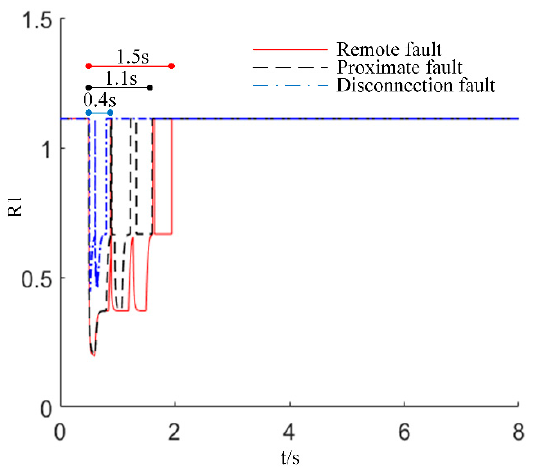
Figure 13. The fuzzy amplitude limiter for R1.